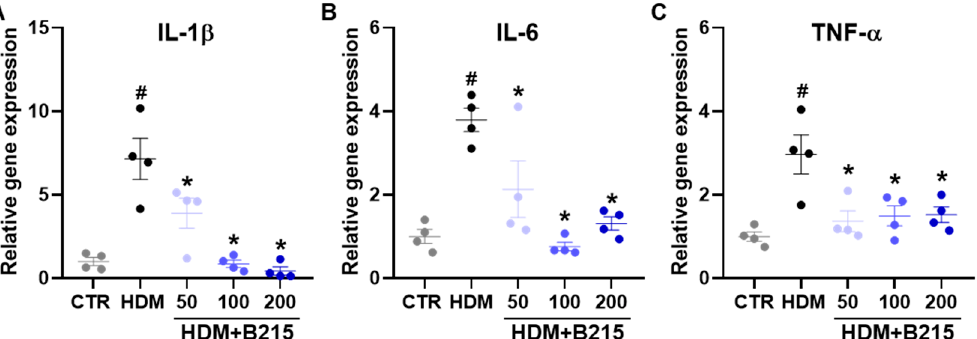
Figure 7. Effect of B215 on pro-inflammatory gene expressions in lungs of HDM-induced mice. Expression of ( A ) IL-1 β , ( B ) IL-6, and ( C ) TNF- α were analyzed with real-time qPCR. Gray, Control; Black, HDM; Light blue, HDM+50B215; Blue, HDM+100B215; Dark blue, HDM+200B215. Data are presented as mean ± SD (# and *, p < 0.05, compared to CTR and HDM, respectively).